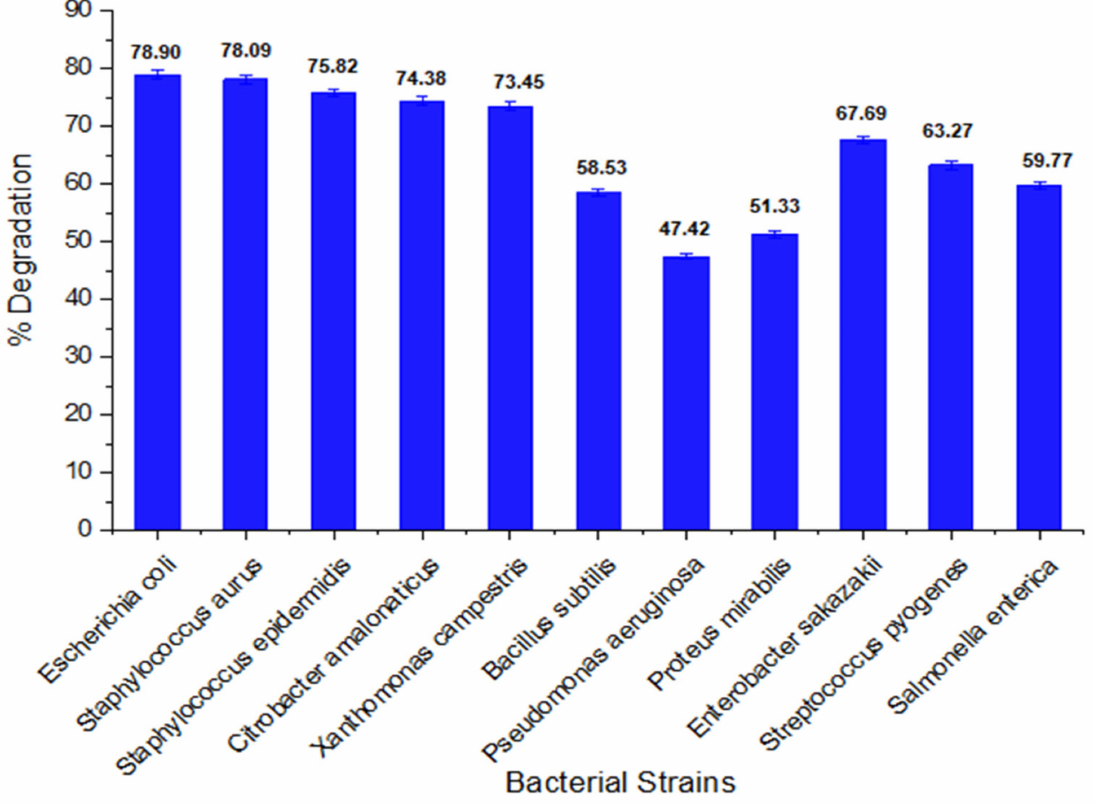
Figure 2. Percentage Degradation of Basic Orange 2 Dye by different Bacterial